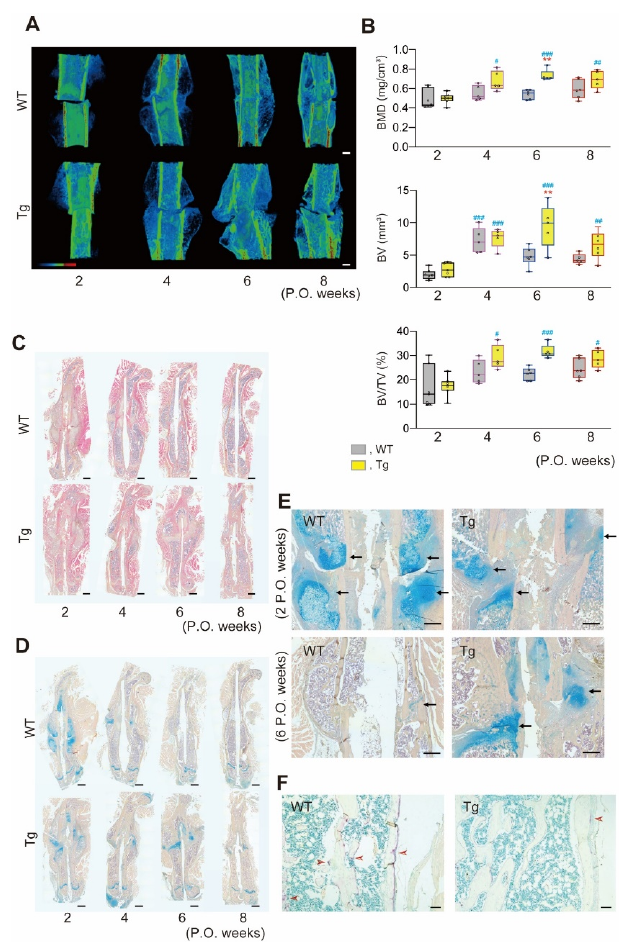
Figure 4. Femoral fracture healing in male Tg and WT mice. ( A ) Representative 3D μ CT images of fractured femurs during postoperative (P.O.) weeks. The gradation panel responds to CT value. Scale bars, 1 mm. ( B ) Callus μ CT parameters. ROI, 3 mm thickness to mesiodistal from the fracture sites. n = 7 – 10. ** p < 0.01 versus WT; # p < 0.05, ## p < 0.01, ### p < 0.001 vs. Tg at 2 P.O. weeks. ( C–F ) Representative histological images of longitudinal sections stained with H-E ( C ), Alcian blue and hematoxylin ( D , E ) and TRAP with methyl green ( F ). High magnification images of callus areas at 2 and 6 P.O. weeks ( E ) and 6 P.O. weeks ( F ). Arrows and arrowheads, cartilage and TRAP + cells, respectively. Scale bars, 1.25 mm ( C , D ); 600 μ m ( E ); 100 μ m ( F ).